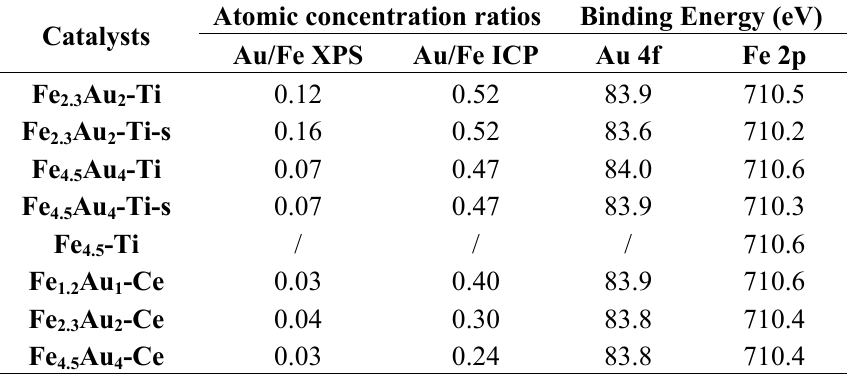
Table 5. Atomic concentration ratios and binding energy of gold and iron in the